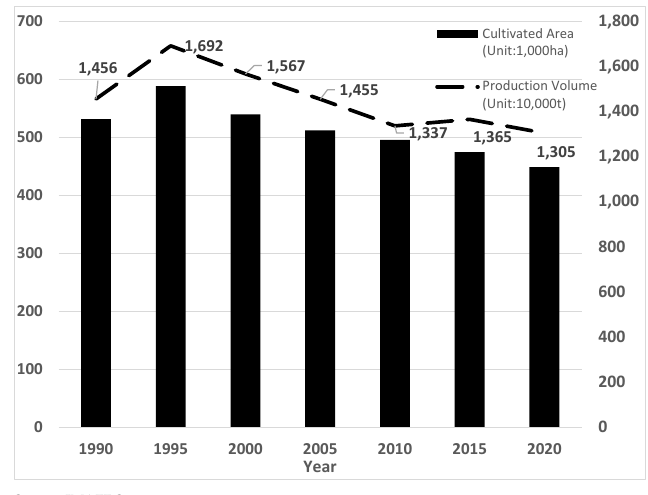
Figure 1. Trends in cultivated area and production volume of vegetables in Japan.